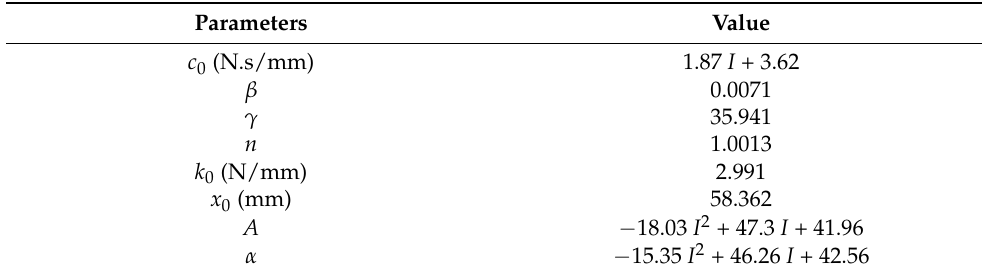
Table 2. Identification result of Bouc-Wen model